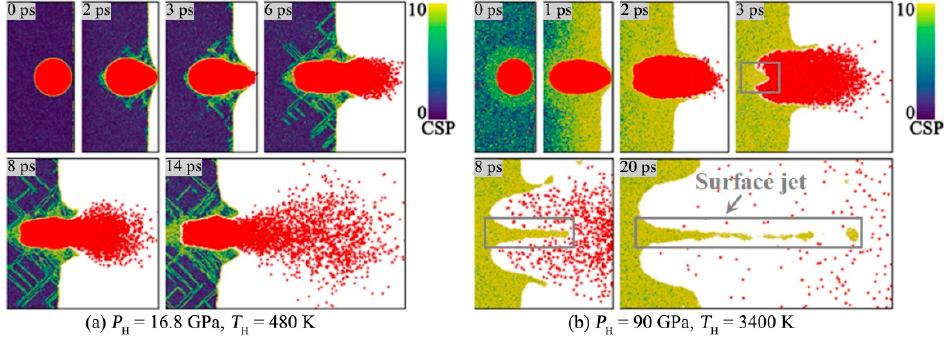
Figure 12. The local microstructure evolution of the He bubble under the case of L = 76 a for ( a ) P H = 16.8 GPa and ( b ) 90 GPa.